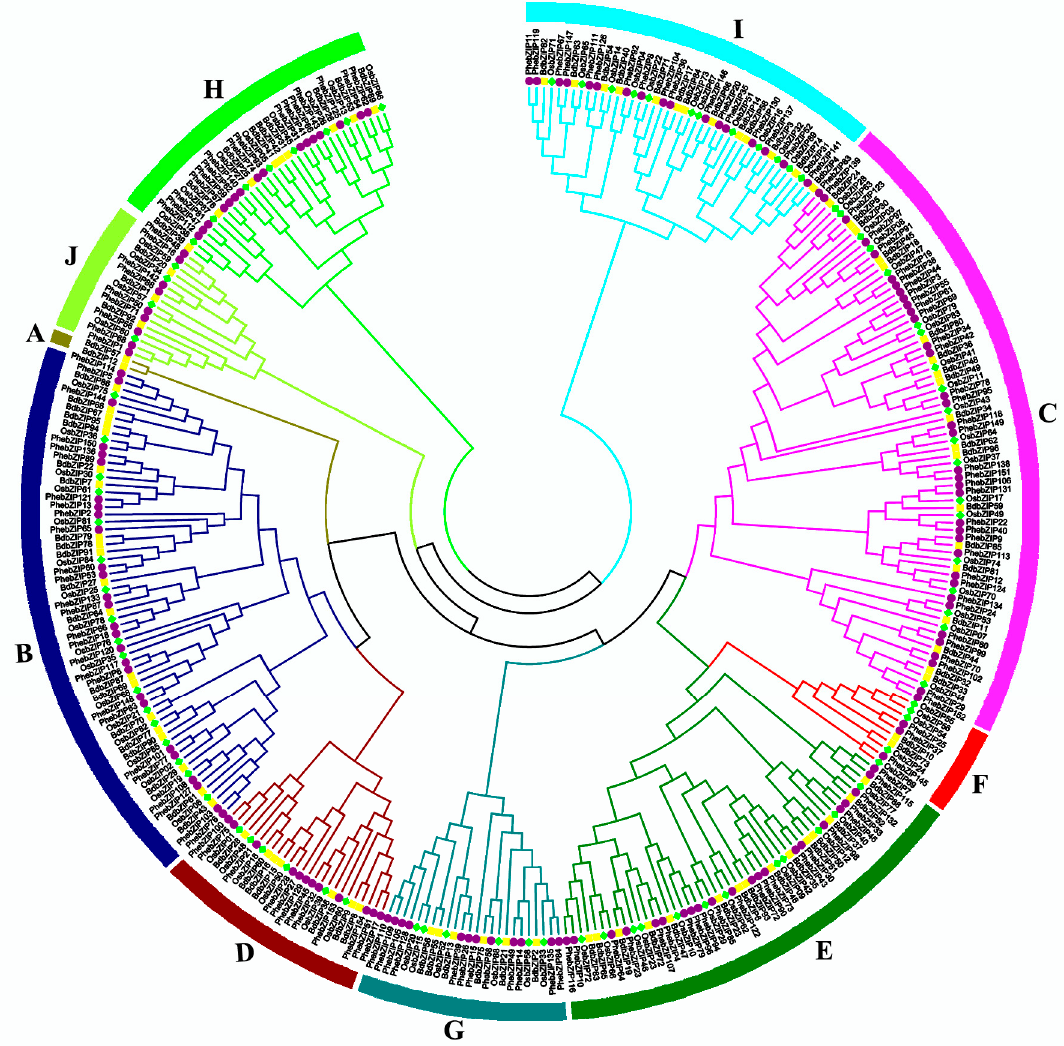
Figure 1. Phylogenetic tree and distribution of bZIP protein from three plant species: rice, Brachypodium distachyon , and moso bamboo. The phylogenetic tree was constructed using the neighbor-joining method as implemented in MEGA6.0 from a bZIP protein sequence alignment. Bootstrap values from 1000 replicates are displayed at each node. The proteins on the tree can be divided into ten clades and the different clades are indicated by different colors.